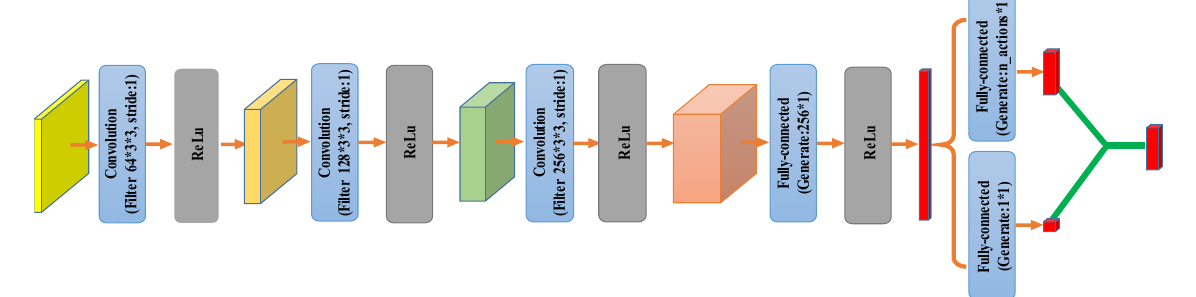
Figure 3. D3QN architecture. The input representations are first down-sampled to 64 × 64 size. It is processed by the D3QN, which predicts the value of the nine actions.